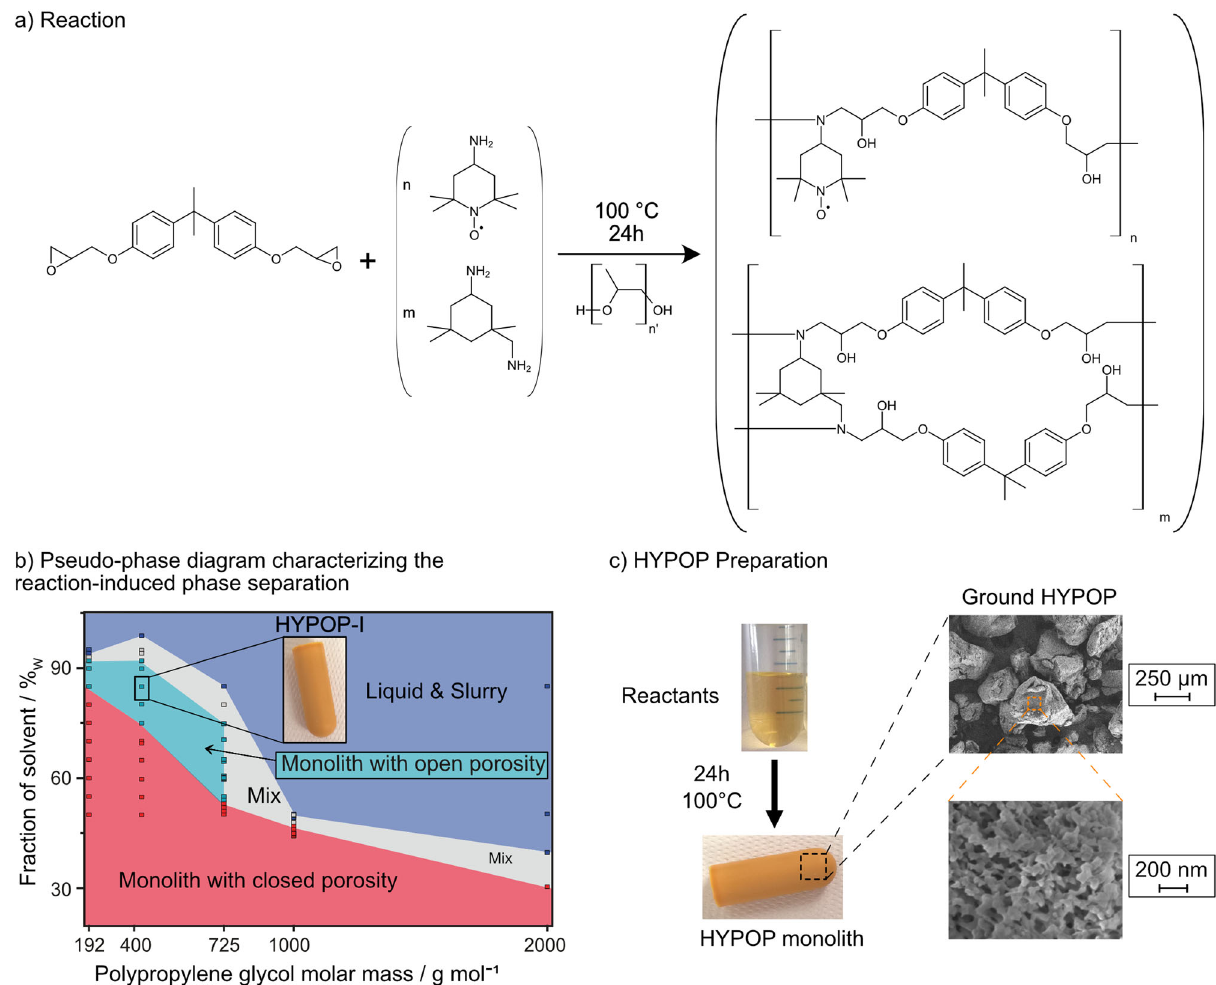
Fig. 2 Synthesis of HYPOP materials. a Synthesis of TEMPO-functional and structured epoxy resins from diglycidyl ether of bisphenol A (DGEBA), isophorone diamine (IPDA) and 4-amino-TEMPO in the presence of various amounts of non-reactive polypropylene glycol (PPG). b The various morphologies obtained in the absence of 4-amino-TEMPO, when varying the fraction and the average molar mass in number (M ̅ n) of PPGs are reported in a pseudo-phase diagram: liquids (slurry and suspensions) in dark blue, solids with closed porosity in red, heterogeneous mixtures of solids and liquids in grey and solids with open porosity in light blue. The highlighted data (85 wt% of PPG-400 g mol − 1 ) corresponds to the HYPOP- I series ( c ) that was functionalized with 4-amino-TEMPO and is reported in the remainder of the